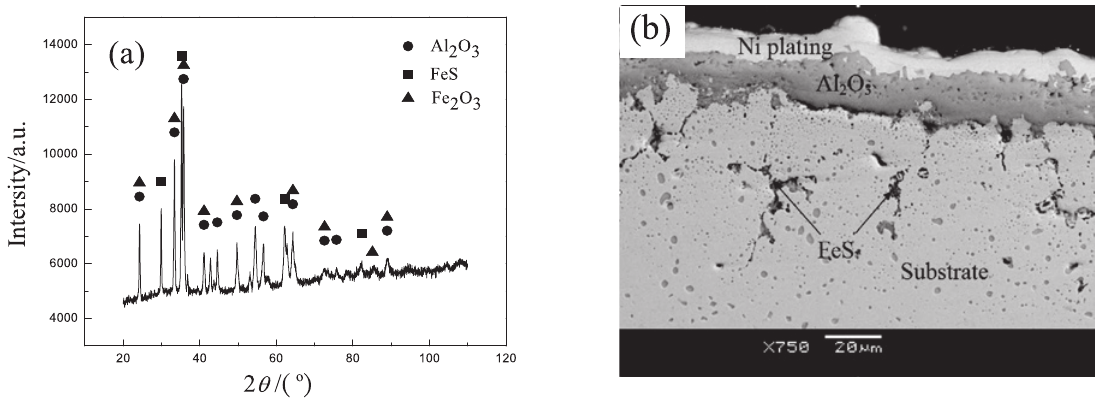
Fig. 5: XRD pattern (a) and cross-sectional morphology (b) of the PO alloy after hot corroded for 24